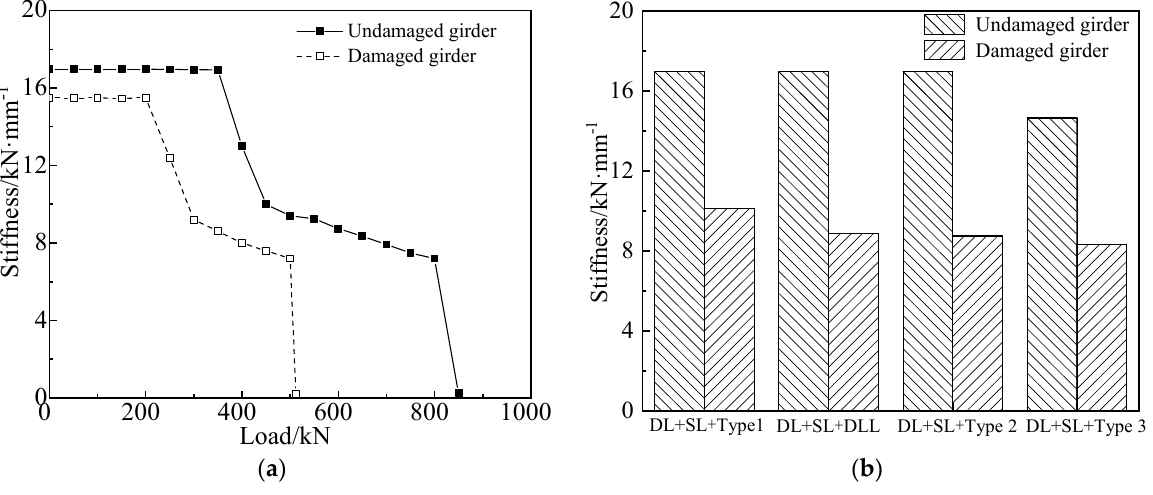
Figure 21. Stiffness comparison due to the destructive tests. ( a ) Load vs. stiffness degradation curve; ( b ) Stiffness degradation under different live loads.